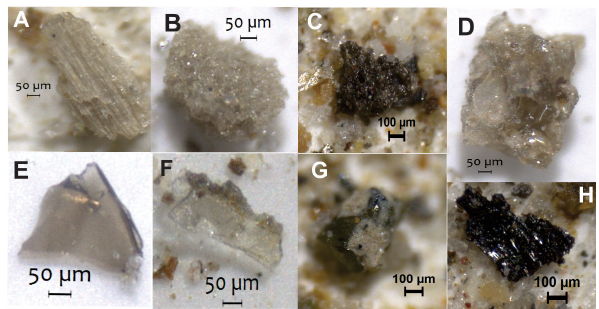
Figure 6. Stereo microscope images of juvenile glass fragments from ashfall events identified in the filters. Different morpholo- gies are shown: (a) colorless glass fragment with elongate, thin, pipe-shaped vesicles (2017 end-of-summer dark layer, site Acc7- 2017). (b) Colorless pumice (surface ablation ice, site Abl6-2017). (c) Dark brown fragment of vesicular glass (2017 end-of-summer dark layer, site Acc7-2017). (d) Glass fragments with smooth, round surfaces formed by surface tension within still-molten, vesiculating droplets suggesting highly vesicular interior (2017 end-of-summer dark layer, site Acc7-2017). (e, f) Two flat, tan glass shards de- rived from broken vesicle walls. Left: Y-shaped fragment formed where three bubbles were in close proximity (surface ablation ice, site Abl6-2017). Right: flat glass plate formed by the fragmentation of walls that enclosed large elongated, flattened vesicles as those shown above (fresh snow on top of ablation ice, site Abl5-2017). (g) Pyroxene crystal with two patches of colorless glass with tiny dots of magnetite (2016 end-of-summer dark layer, site Acc4-2017). (h) Planar piece of charcoal with subtle striated surface texture and bril- liant luster.